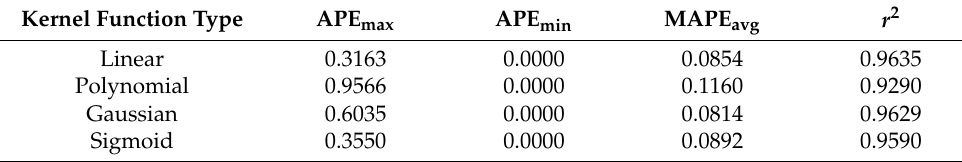
Table 3. Comparison of forecasting performance on the training set.